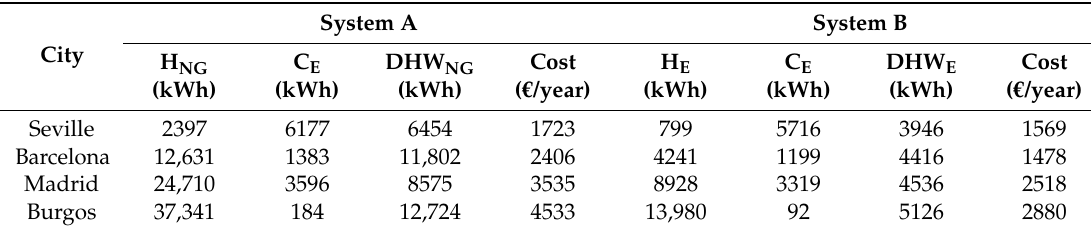
Table 8. Yearly cost of final energy consumed by systems A and B.